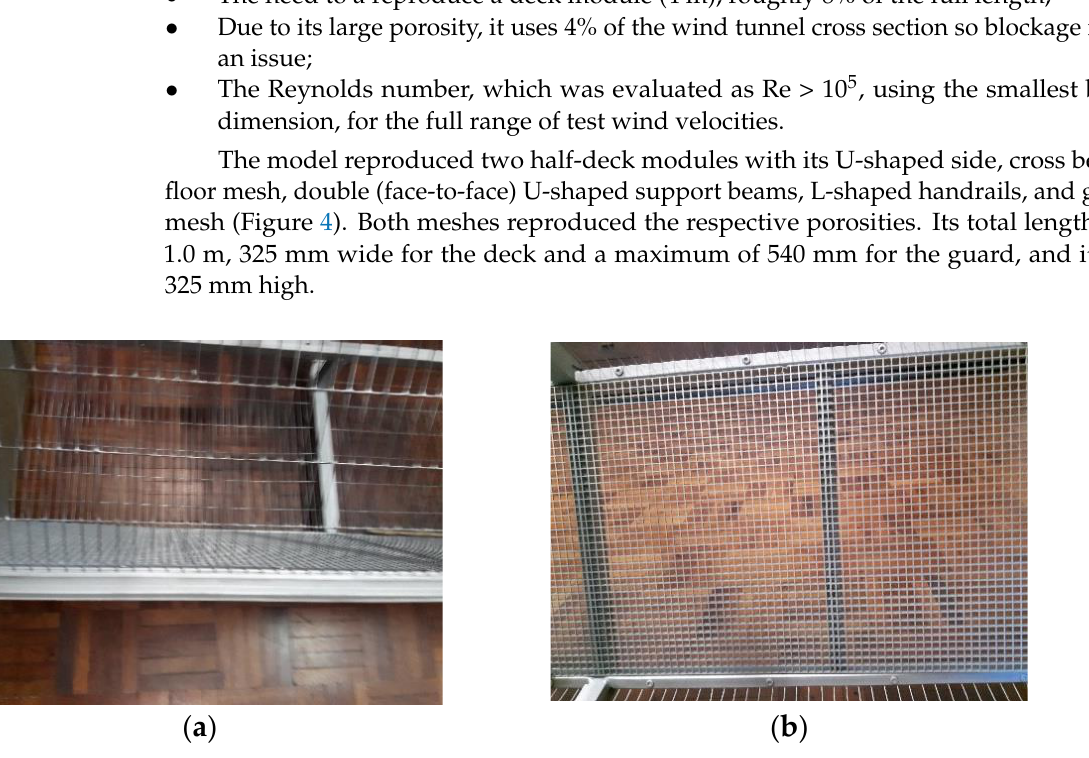
Figure 4. The model ’ s: ( a ) deck beam and guard mesh, and ( b ) deck mesh. Figure 4. The model’s: ( a ) deck beam and guard mesh, and ( b ) deck mesh. In order to keep a 2D flow, avoiding 3D effects around the model tops, thin flat end plates with rounded corners were installed (Figure 5). Connecting to the end plates’ sets of supporting external horizontal beams allowed to suspend the model inside the wind tunnel, the attachment point coinciding with the gravity